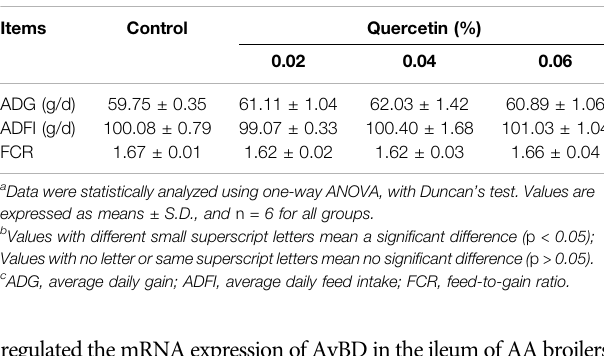
TABLE 6 | Effect of quercetin on the growth performance of AA